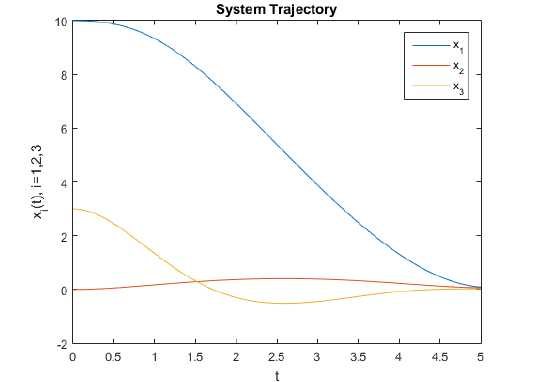
Figure 2. State trajectories x 1 , x 2 and x 3